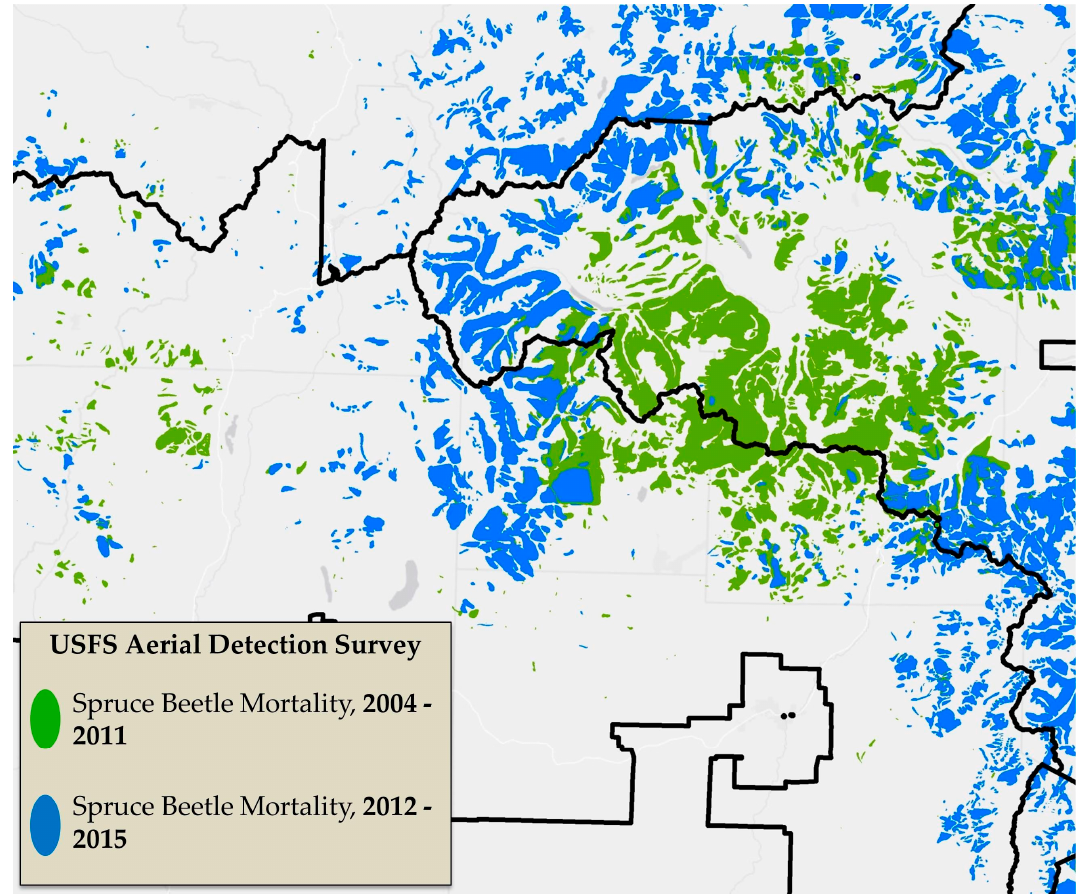
Figure 6. Spruce beetle-induced mortality as documented by the USFS Aerial Detection Survey (ADS) between 2004 and 2015. There is a close match between the general location and timing of mortality events as documented by ADS and our models. Data provided by Pete Barry, Colorado State Forest Service.